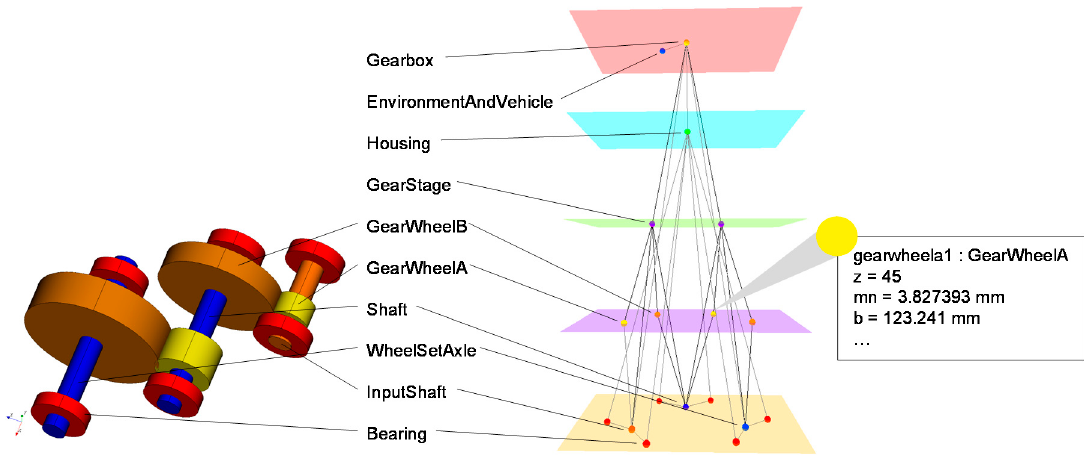
Figure 12. Graph of instances which represent the components of one typical variant of gear system (Instance attributes: z = number of teeth; mn = normal modul; b = width).